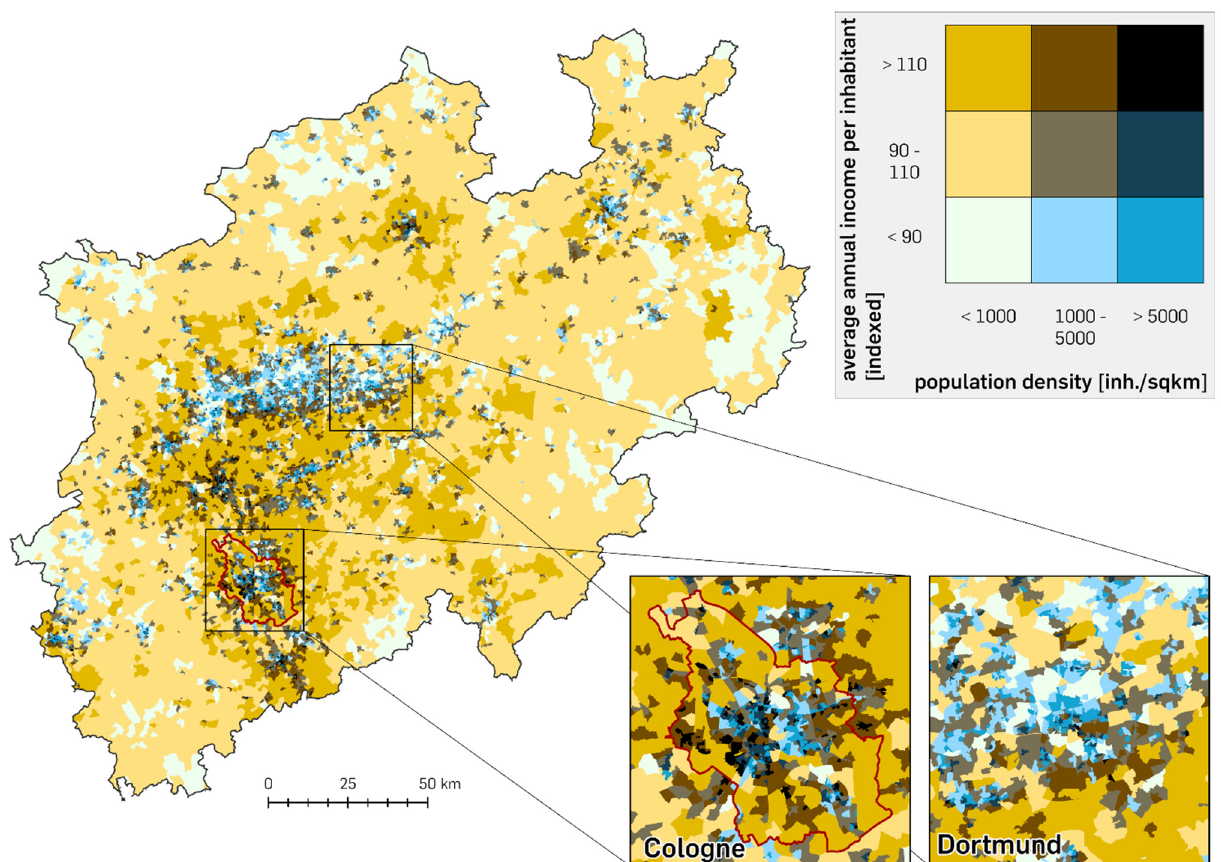
Figure 7. Bivariate choropleth map showing the combination of population density and average annual income per inhabitant (Data source: [22,23,25]).